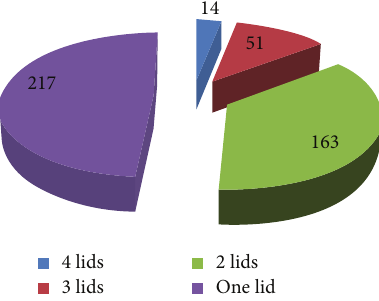
Figure 2: Number of affected lids per